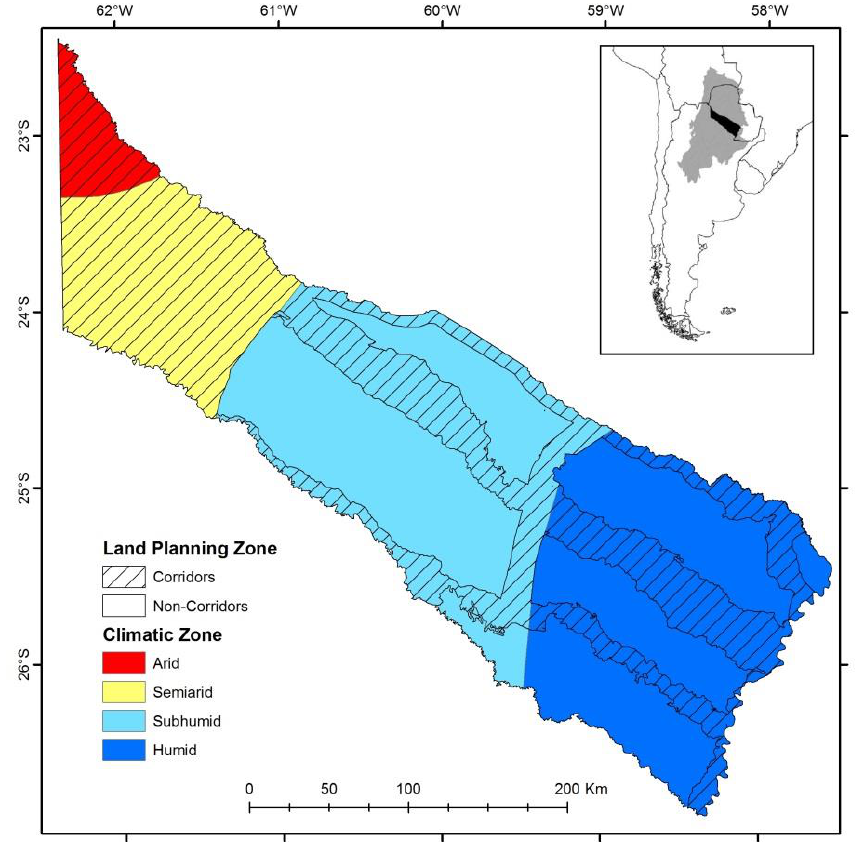
Figure A2.1. Province stratification for the simulation of deforestation according to land planning zones and climatic